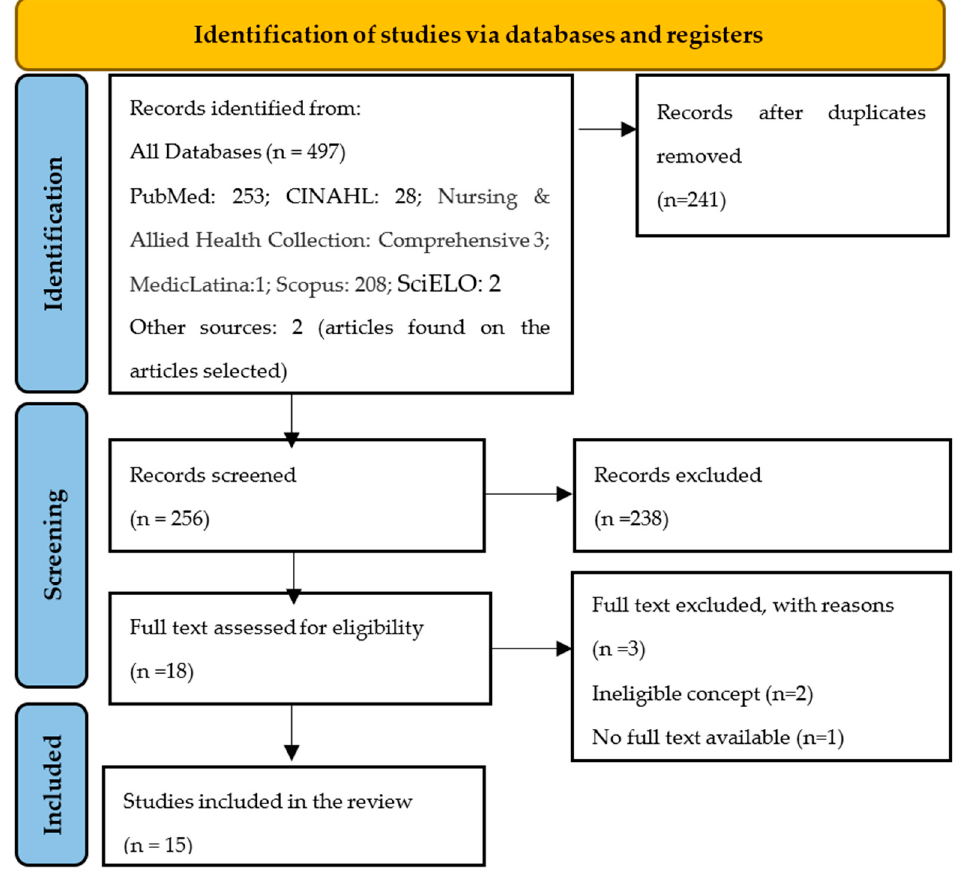
Figure 1. Flowchart of the selection and screening process of the systematic review articles according to the PRISMA method.